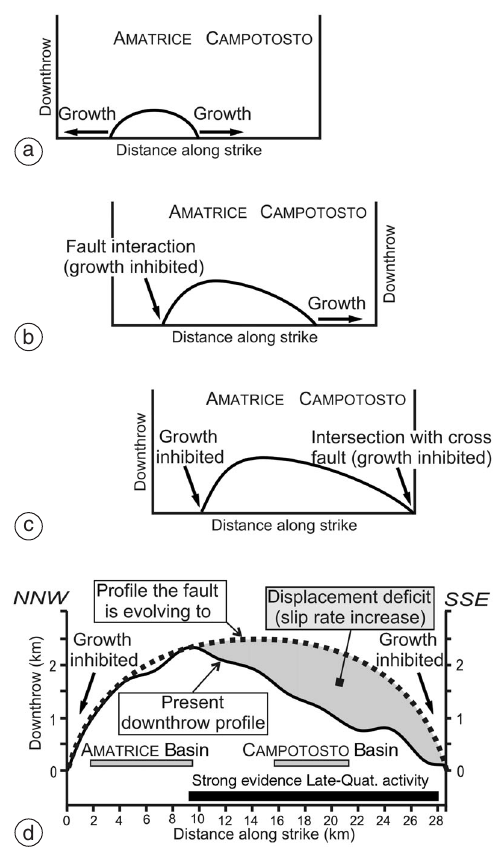
Fig. 9a-d. Schematic evolutionary history of the Mt. Gorzano Fault and related displacement profile: a) fault nucleates and freely grows displacing pre- existing contractional structures; b) fault interacts at NNW with the right-stepping Mt. Vettore normal fault; interaction inhibits fault growth towards NNW and displacement gradient increases producing an asymmetric profile; fault freely grows toward SSE; c) fault intersect at SSE the E-W-trending Gran Sas- so normal fault; intersection inhibits fault growth to- wards SSE. d) Present displacement profile and ide- alized symmetrical profile toward which the fault is evolving to, without further along-strike growth (in- hibited by structural complexities): the grey area de- notes the displacement deficit the fault has to fill, by relative increase in slip rate, to reach the symmetri- cal profile; relative increase in slip rate manifests with strong evidence of fault activity during Late